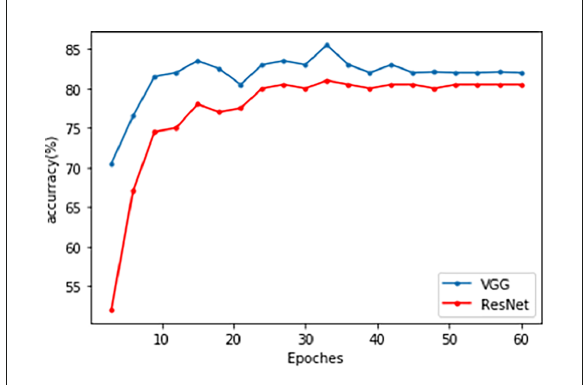
FIGURE3 The accuracy line chart of the VGG and ResNet models training. The blue line is VGG, and the red line is ResNet.